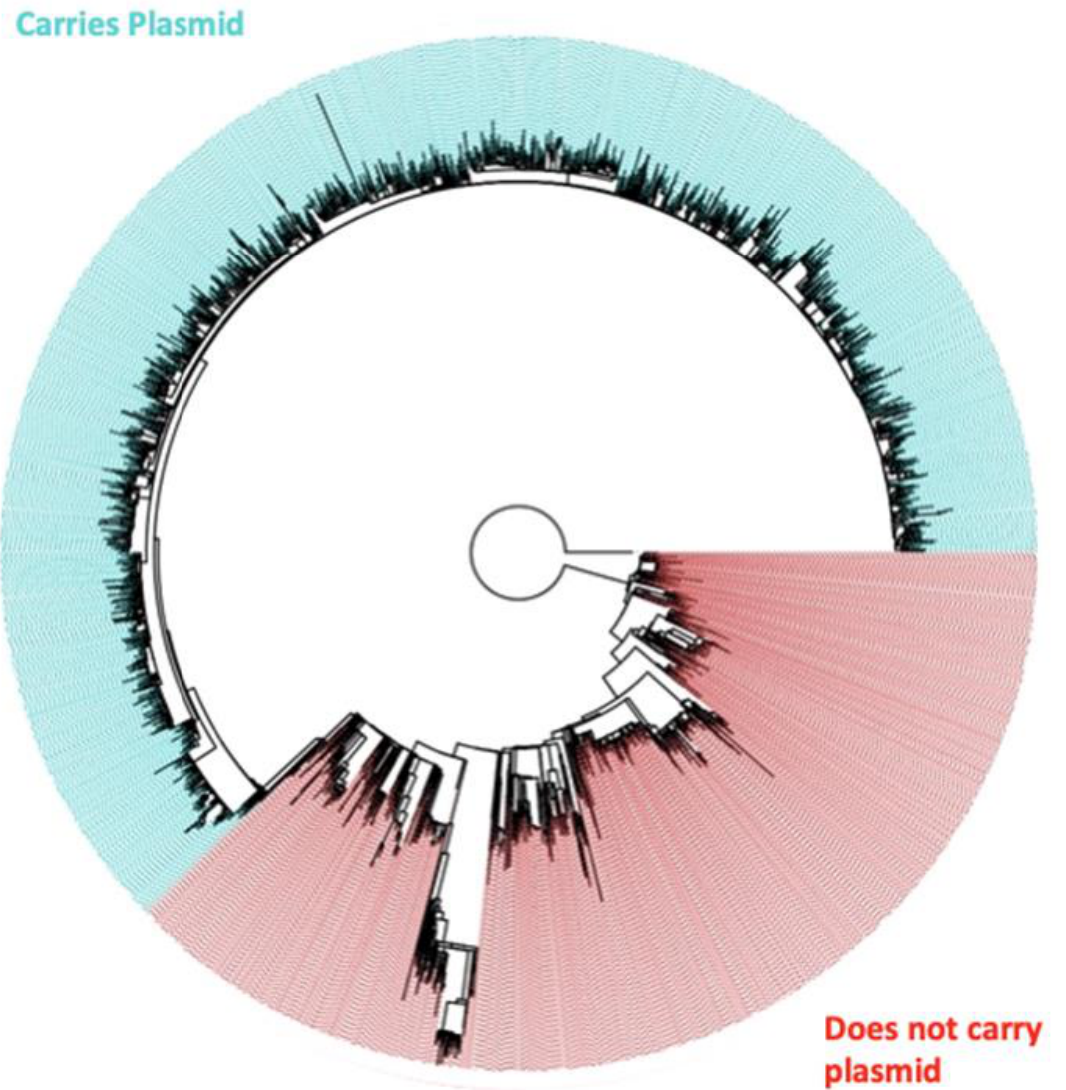
Figure 3. Phylogenetic tree of all Salmonella Infantis strains included in the analysis colored by plasmid carriage.